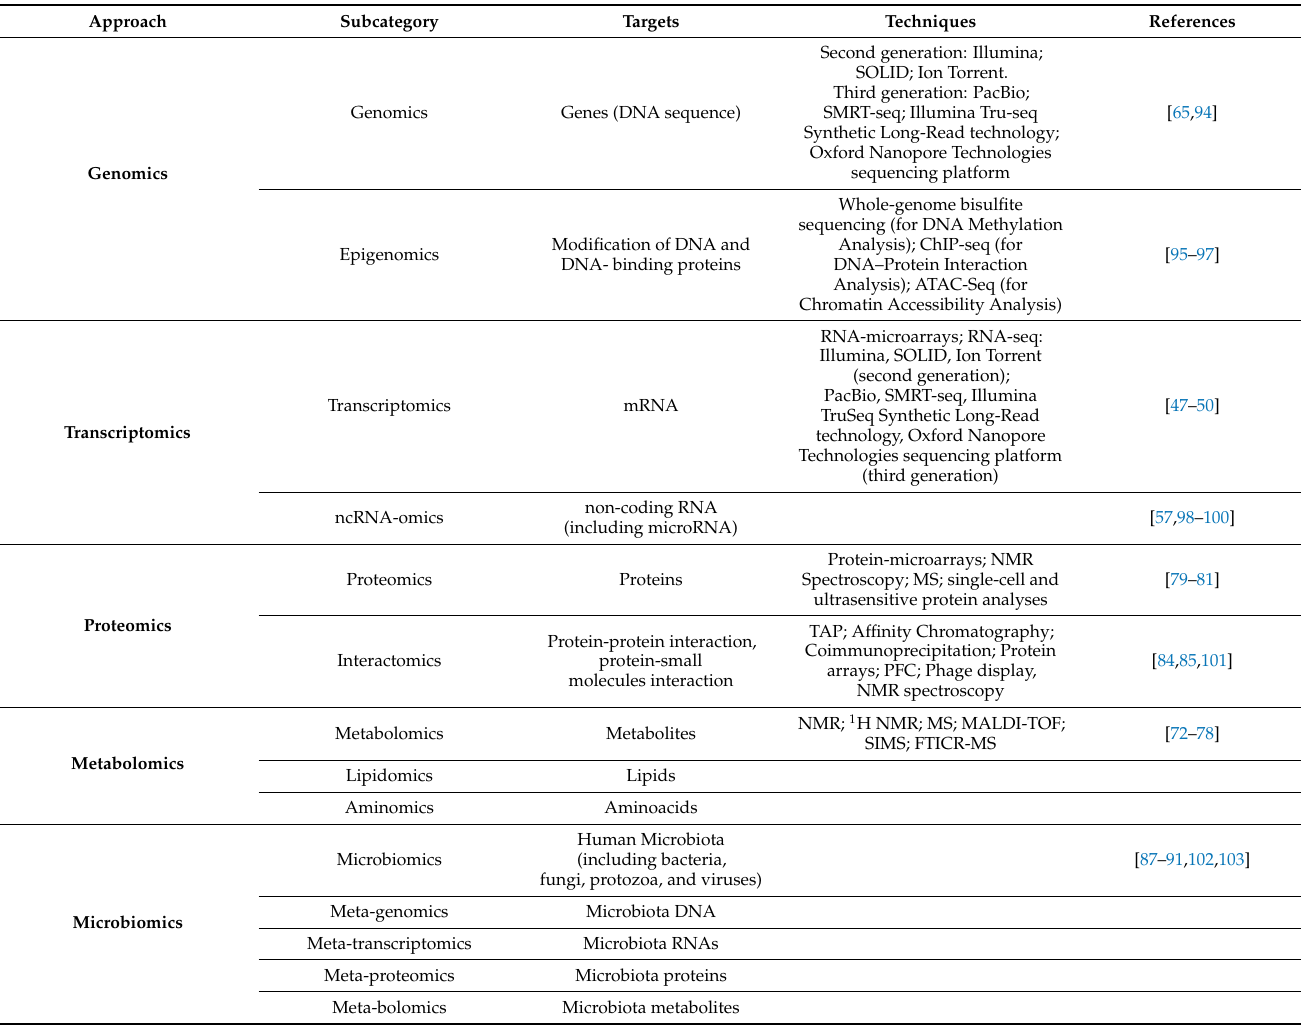
Table 1. Examples of ‘omics’ approaches and emerging technologies employed in nutritional research. Five major categories and their subcategories are